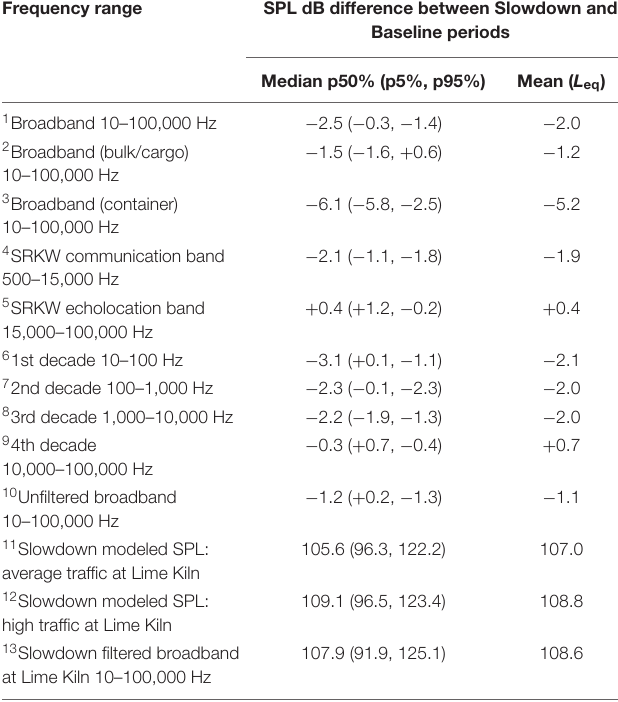
TABLE 6 | Quantiles of the broadband ambient SPL (10 Hz to 100 kHz dB re 1 µ Pa) for two Baseline months and the 61-day Slowdown trial measured on Lime Kiln